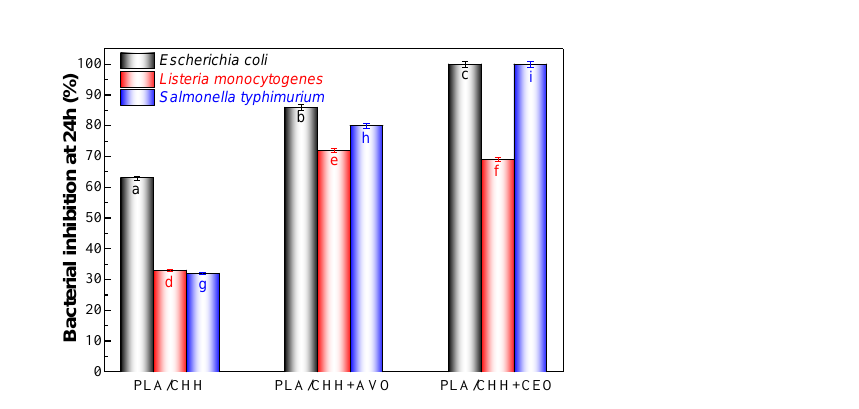
Figure 7. Variation of bacteria percentage inhibition determined by the CHH and oil-loaded CHH coatings. The data are expressed as mean ± standard deviations from triplicate determinations. a – d Mean values with different letters indicate significant differences at p < 0.05.